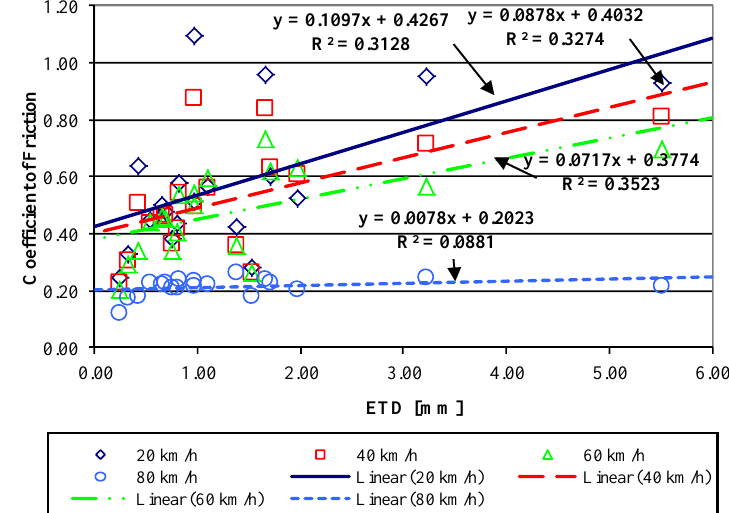
Fig. 6. CT meter ETD versus friction coefficients at varying